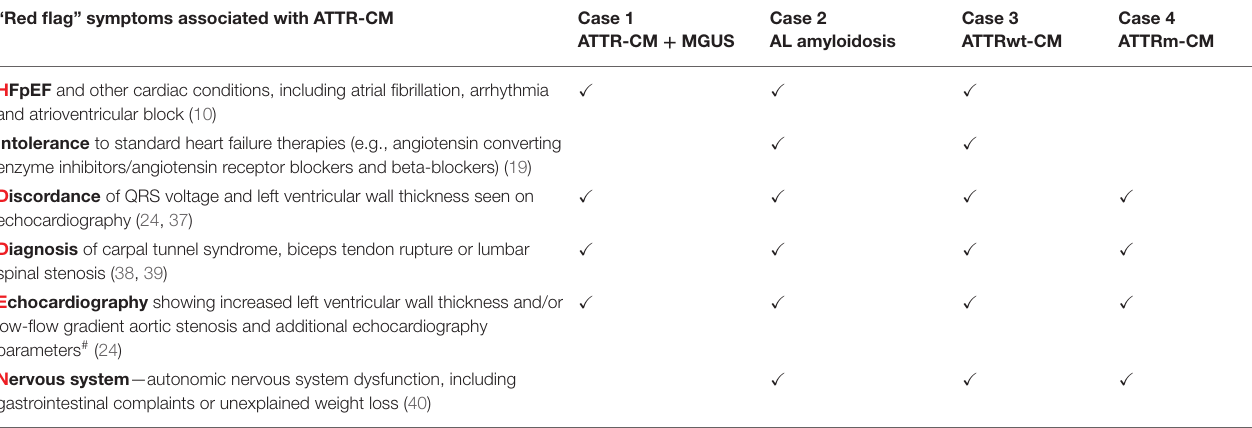
TABLE 1 | Summary of commonly encountered “red flag” symptoms associated with ATTR-CM from the HIDDEN mnemonic present in each illustrative case. “Red flag” symptoms associated with ATTR-CM Case 1